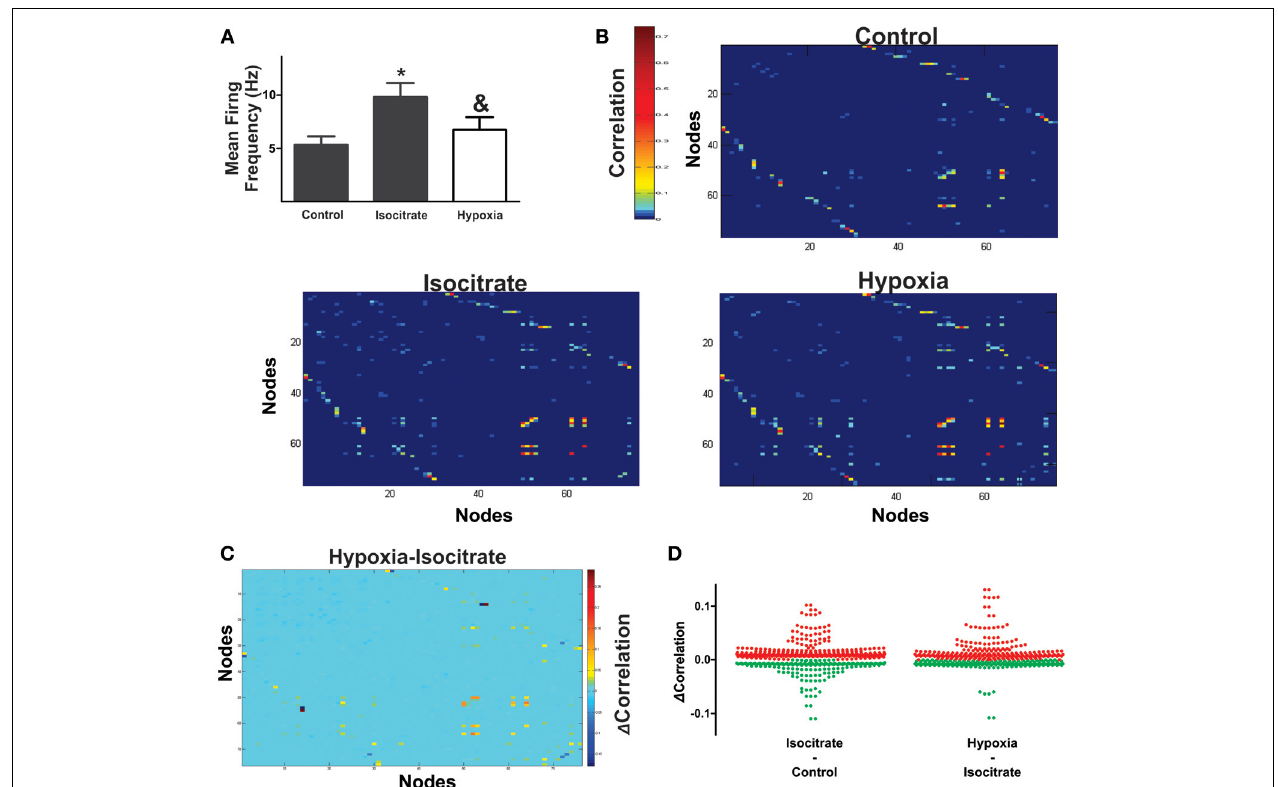
FIGURE 5 | Isocitrate increases functional interactions among respiratory elements and increases correlated firing in hypoxia. (A) Histogram of the normalized mean firing frequency recorded in the control, during the last minute of isocitrate application (which lasted 60min) and under hypoxic conditions in the presence of isocitrate (which lasted 15min; n = 7 slices from different animals). ∗ Denotes a difference with respect to control, and & denotes a difference with respect to isocitrate ( p < 0 . 05). (B) Pseudocolored correlation matrices between all pairs of recording elements in a representative slice (control) and in the same slice in the presence of isocitrate and further application of hypoxia. Color scale indicates the extent of correlation. Note more correlated element pairs after isocitrate and during hypoxia in the